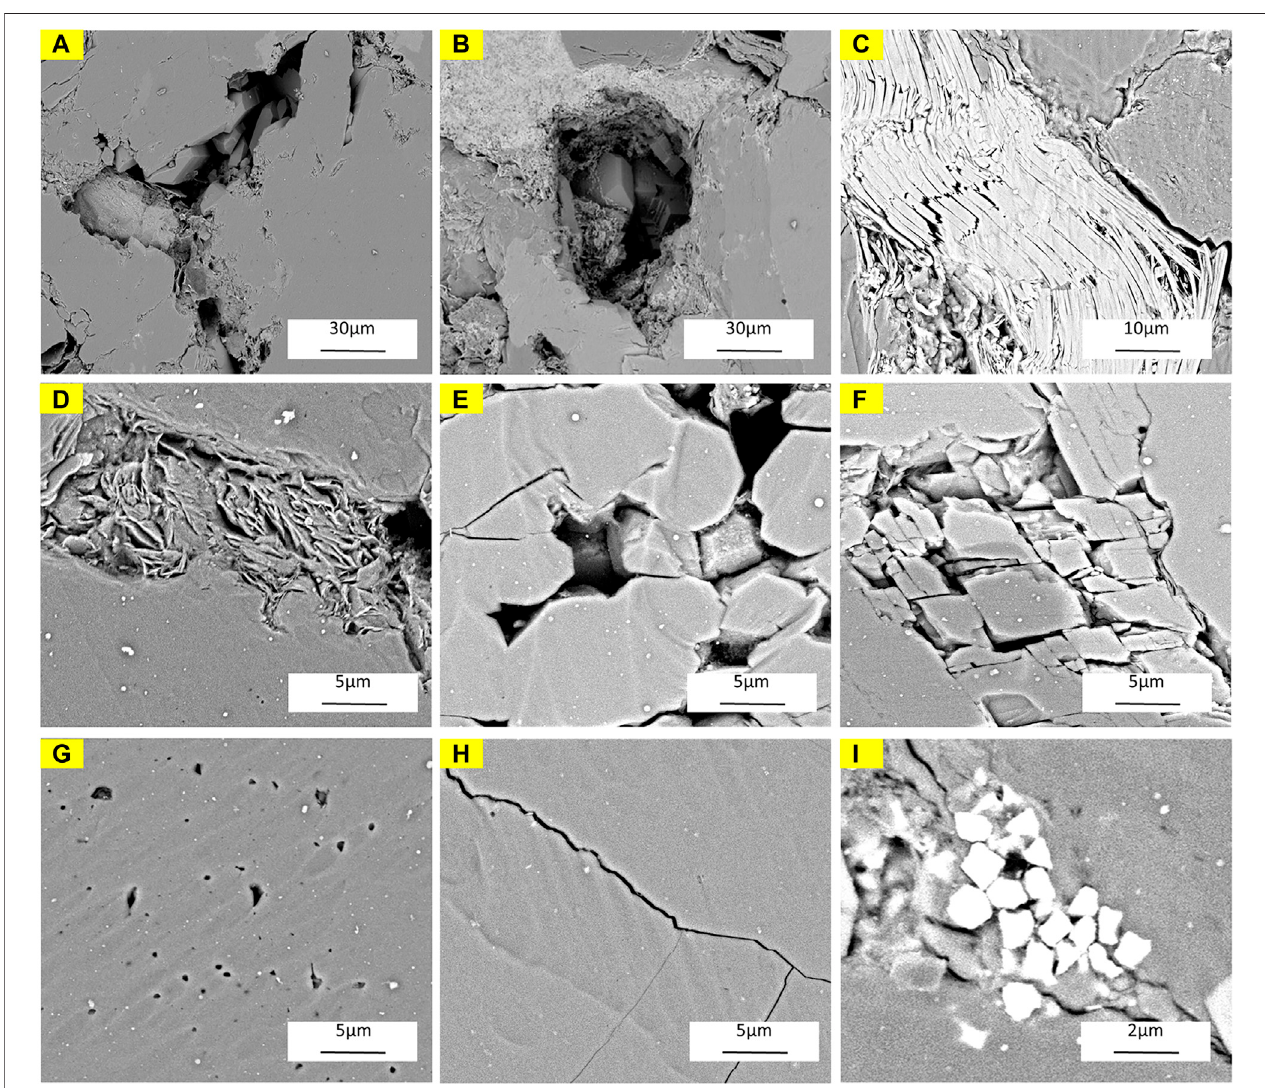
FIGURE3| TypicalSEMphotosofporethroatstructures: (A) Intergranularpores; (B) Intergranulardissolvedpores; (C) Intercrystallinepores(Inter-micapores); (D) Intercrystalline pores (Inter-illite pores), (E) Intergranular pores (Inter-quartz-feldspathic pores); (F) Intercrystalline pores (Inter-calcite pores); (G) Intragranular dissolved pores; (H) Micro-fractures; (I) Intercrystalline pores (Inter-pyrite pores).